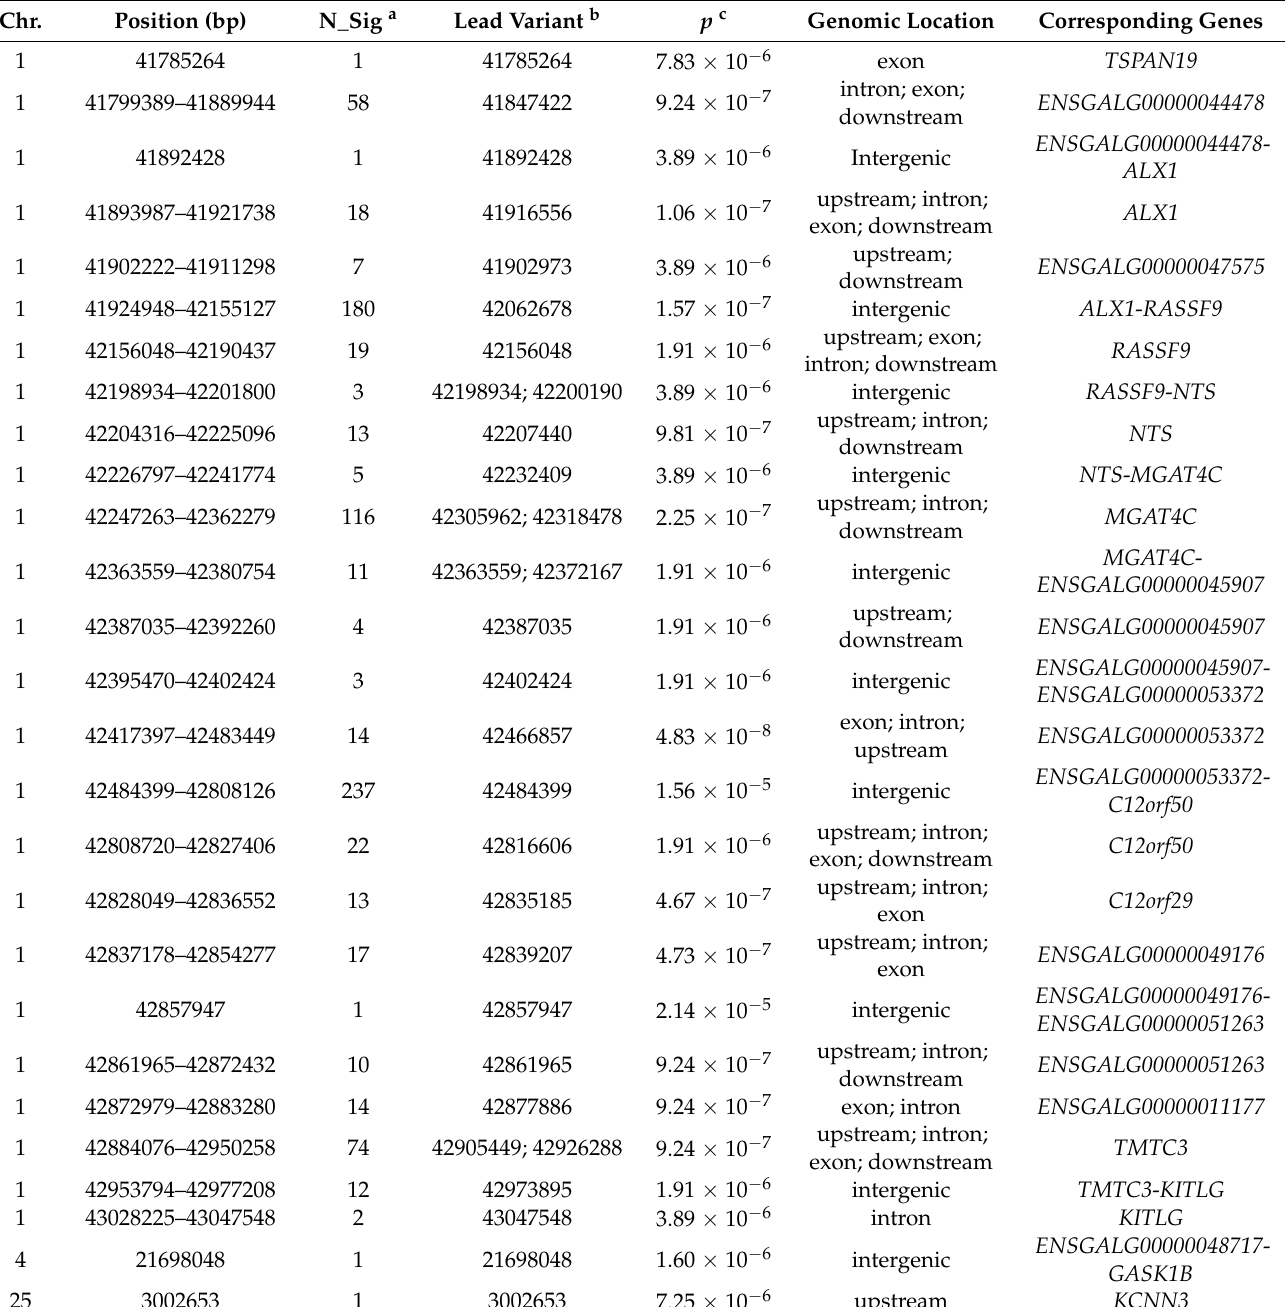
Table 2. A descriptive summary of significant variants associated with the RIR stripe pattern in